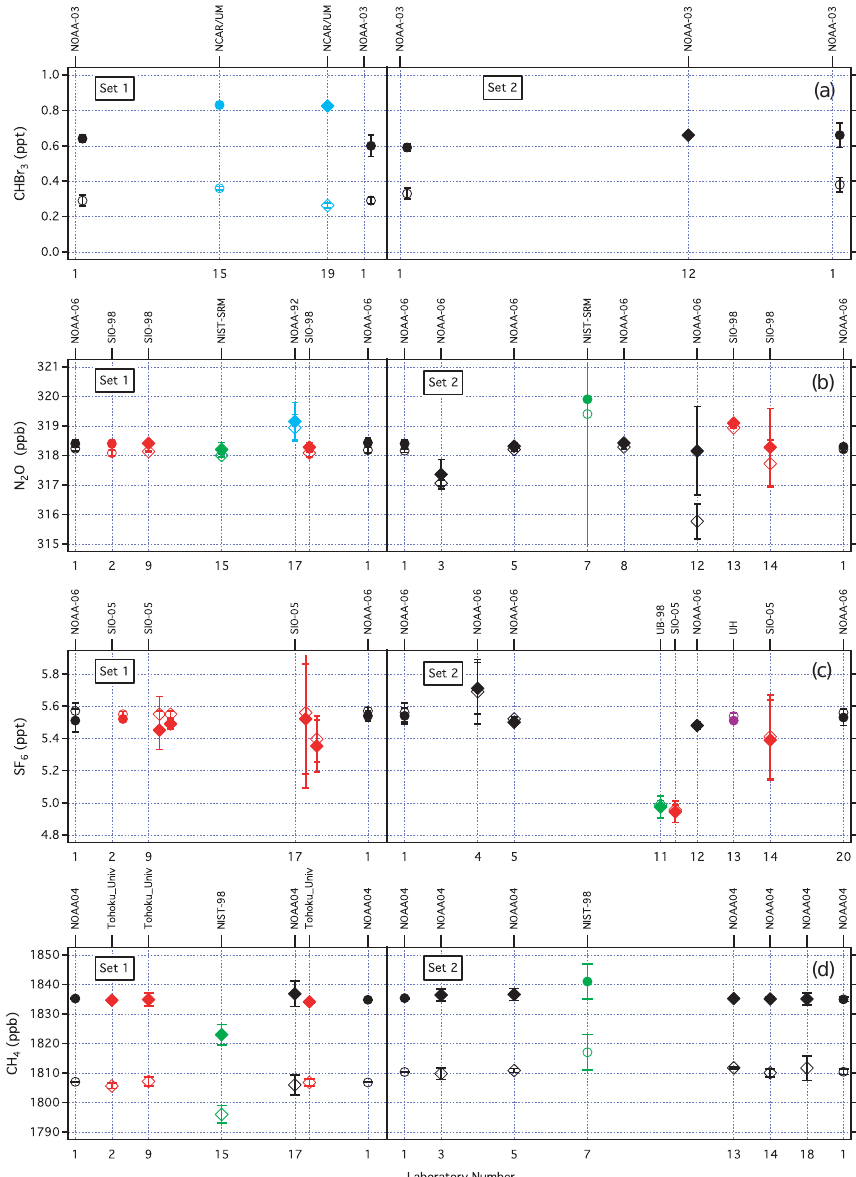
Fig. 6. Same as Fig. 1 for trace gases (a) CHBr 3 , (b) N 2 O, (c) SF 6 , (d) CH 4 (N 2 O and CH 4 in nmolmol − 1 =